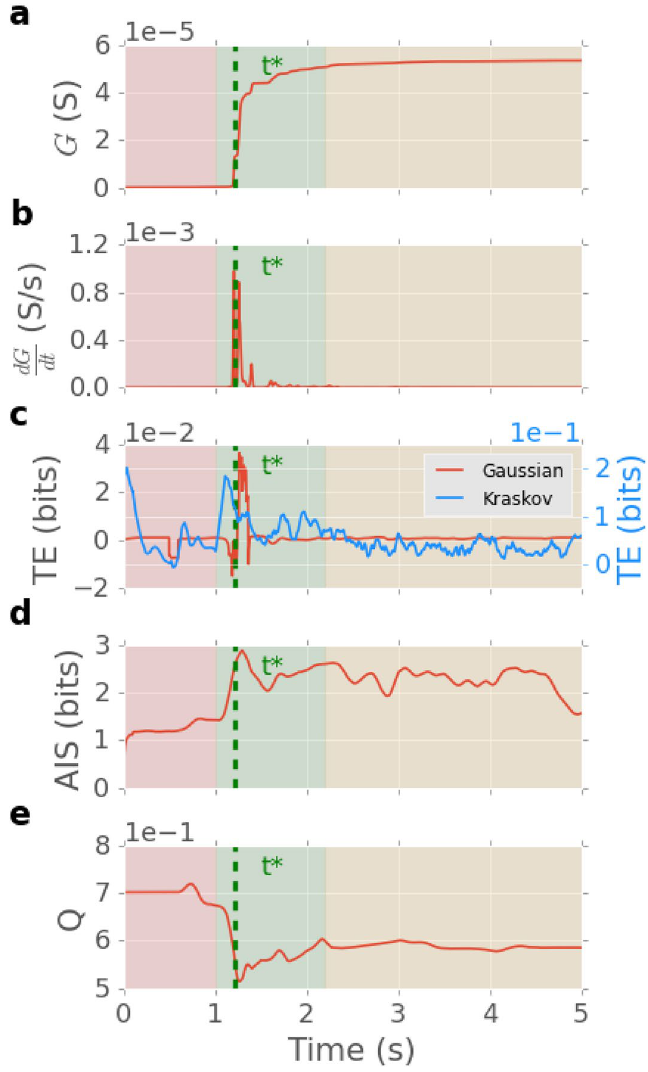
Figure 3. Network time series. ( a ) Network conductance G . ( b ) Time derivative of G . ( c ) Transfer entropy TE, calculated with the Gaussian and Kraskov estimators and averaged over all junctions. ( d ) Active information storage AIS. ( e ) Network modularity Q . Red, green and beige shaded regions indicate pre-activation, activation and post-activation periods, respectively, for a Mackey-Glass input signal. The dashed vertical green line indicates the activation time, t ∗ = 1.22 s, coinciding with formation of the first current